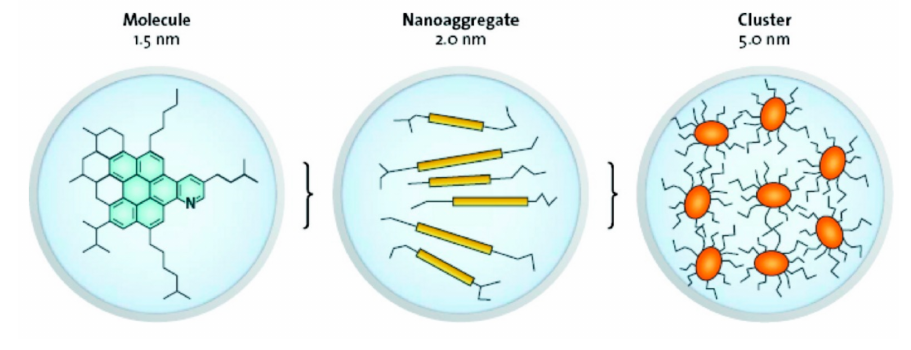
Figure 4. Modified Yen model